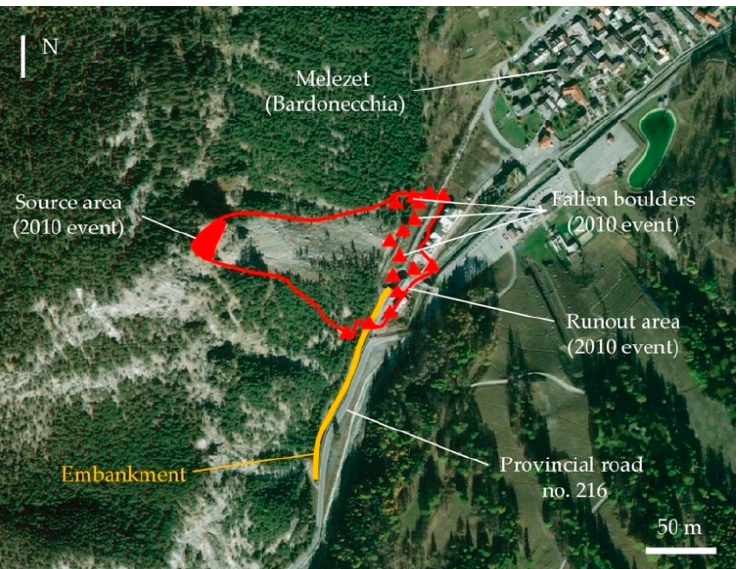
Figure 15. Map of the 2010 event. The red line highlights the runout area of the phenomenon and the red triangles define the location of the observed fallen blocks. The embankment (yellow line), located along the provincial road, was impacted by a cluster of boulders in the southern part of the runout zone.